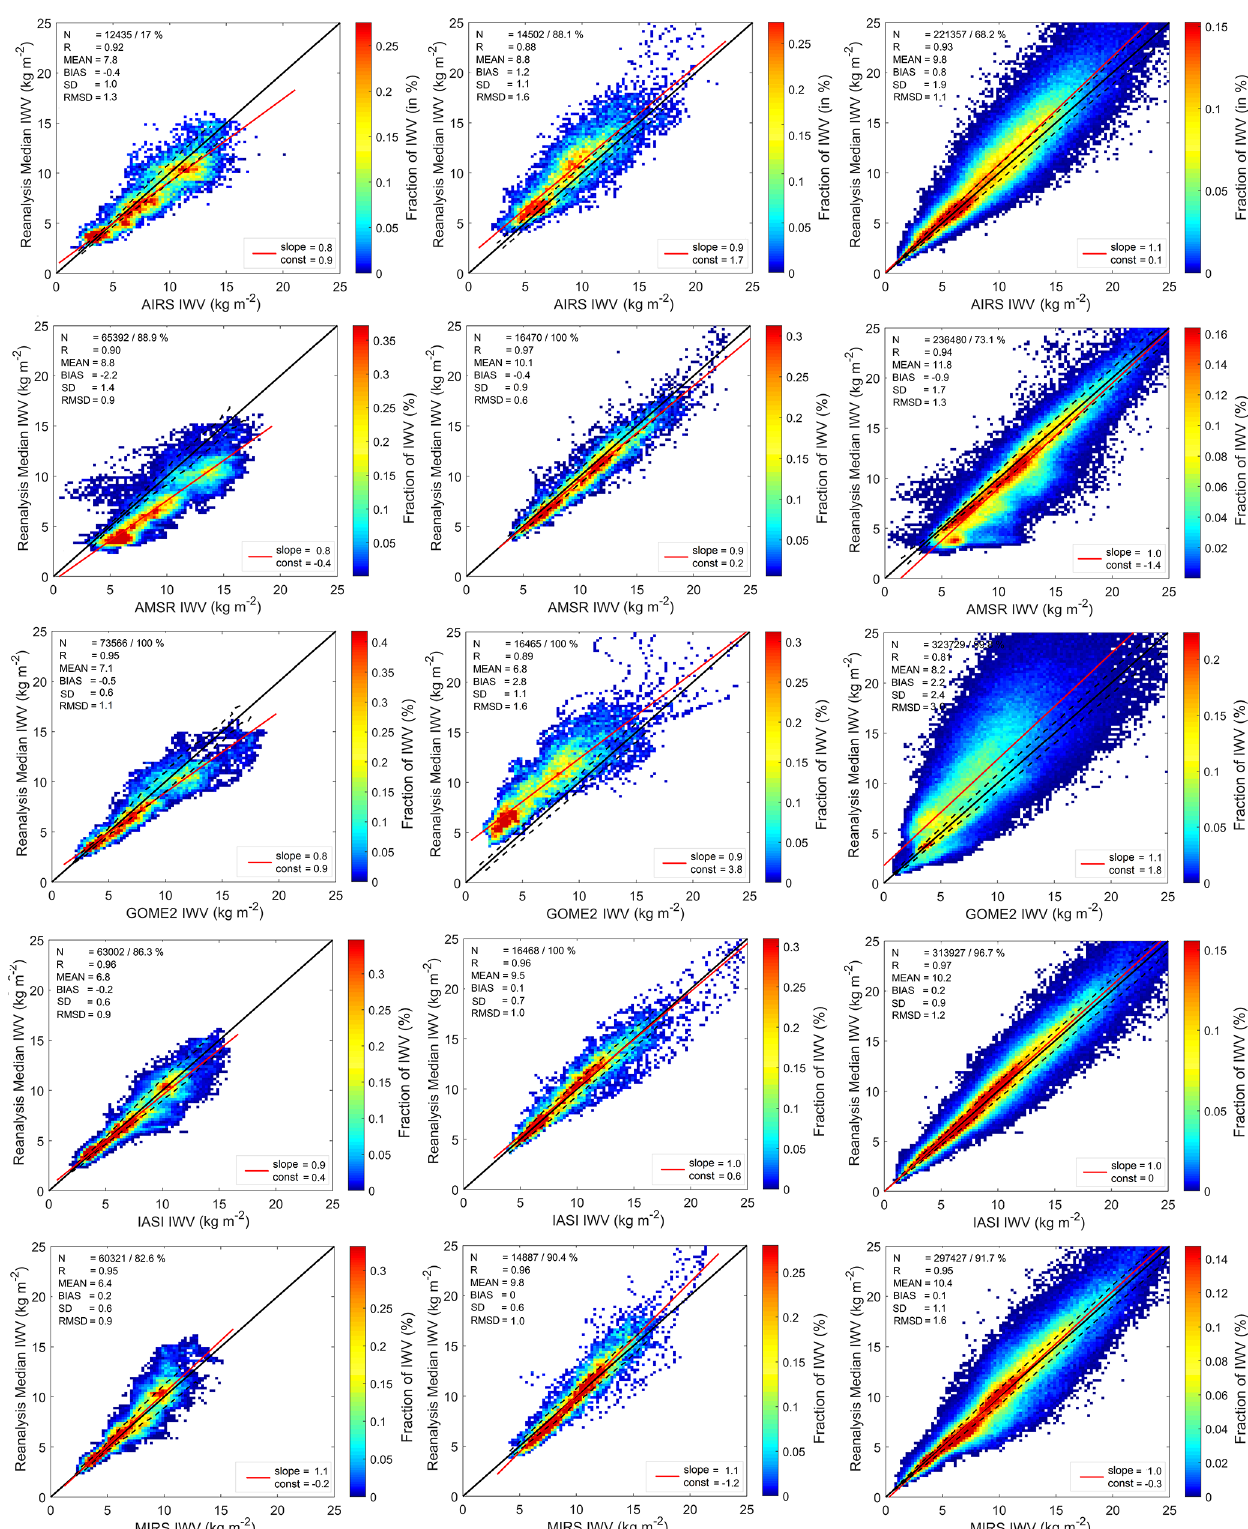
Figure 7. Joint distribution of daily means from the satellite ( x axis; AIRS L2 v6 IR-Only, AMSR, GOME-2, IASI L2 PPFv6, MIRS) and reanalysis median ( y axis: CFSR, ERA-Interim, JRA-55, MERRA2) for the 0.75 ◦ × 0.75 ◦ grid points in the central Arctic (left), open ocean (middle) and the full region (right). The time period is May to June 2017. The color indicates the relative fraction of the